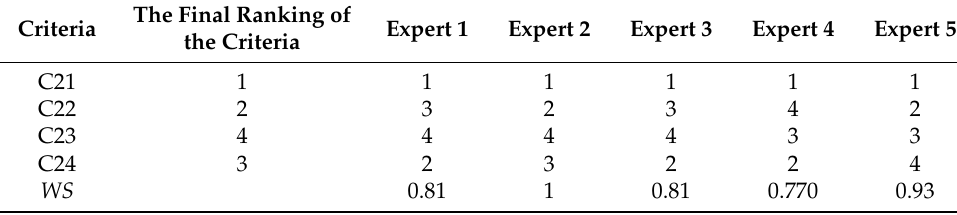
Table 9. The WS coefficients of the sub-criteria of C2.